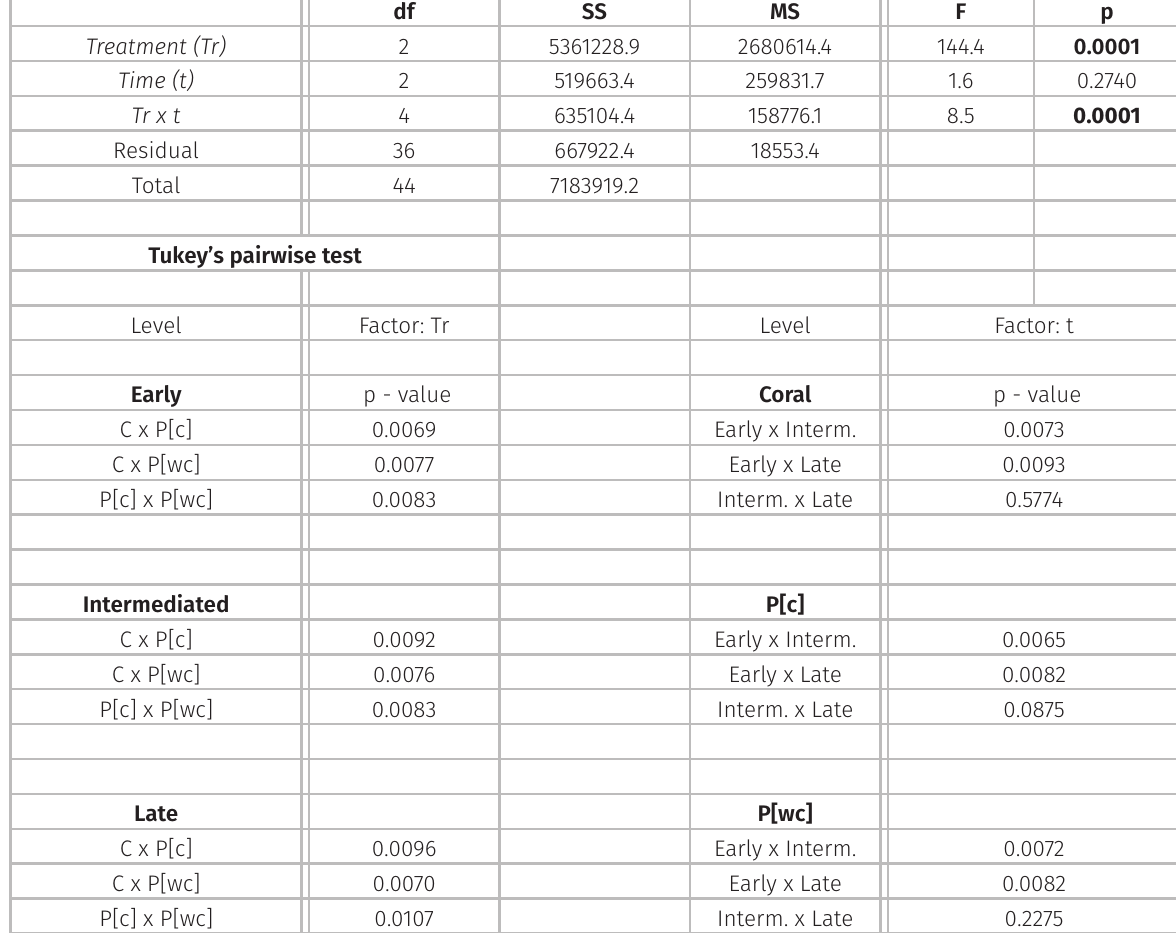
Table II. Permutational multivariate analysis of variance (PERMANOVA). Comparison of the algal species compositions recruited among the factors: treatment (scraped coral (C)), recruitment plates in the region with corals (P[c]) and without corals (P [wc]), and time (early, intermediated, and late). Degrees of freedom (df), sum of squares (SS), and mean squares (MS). *Significant results in